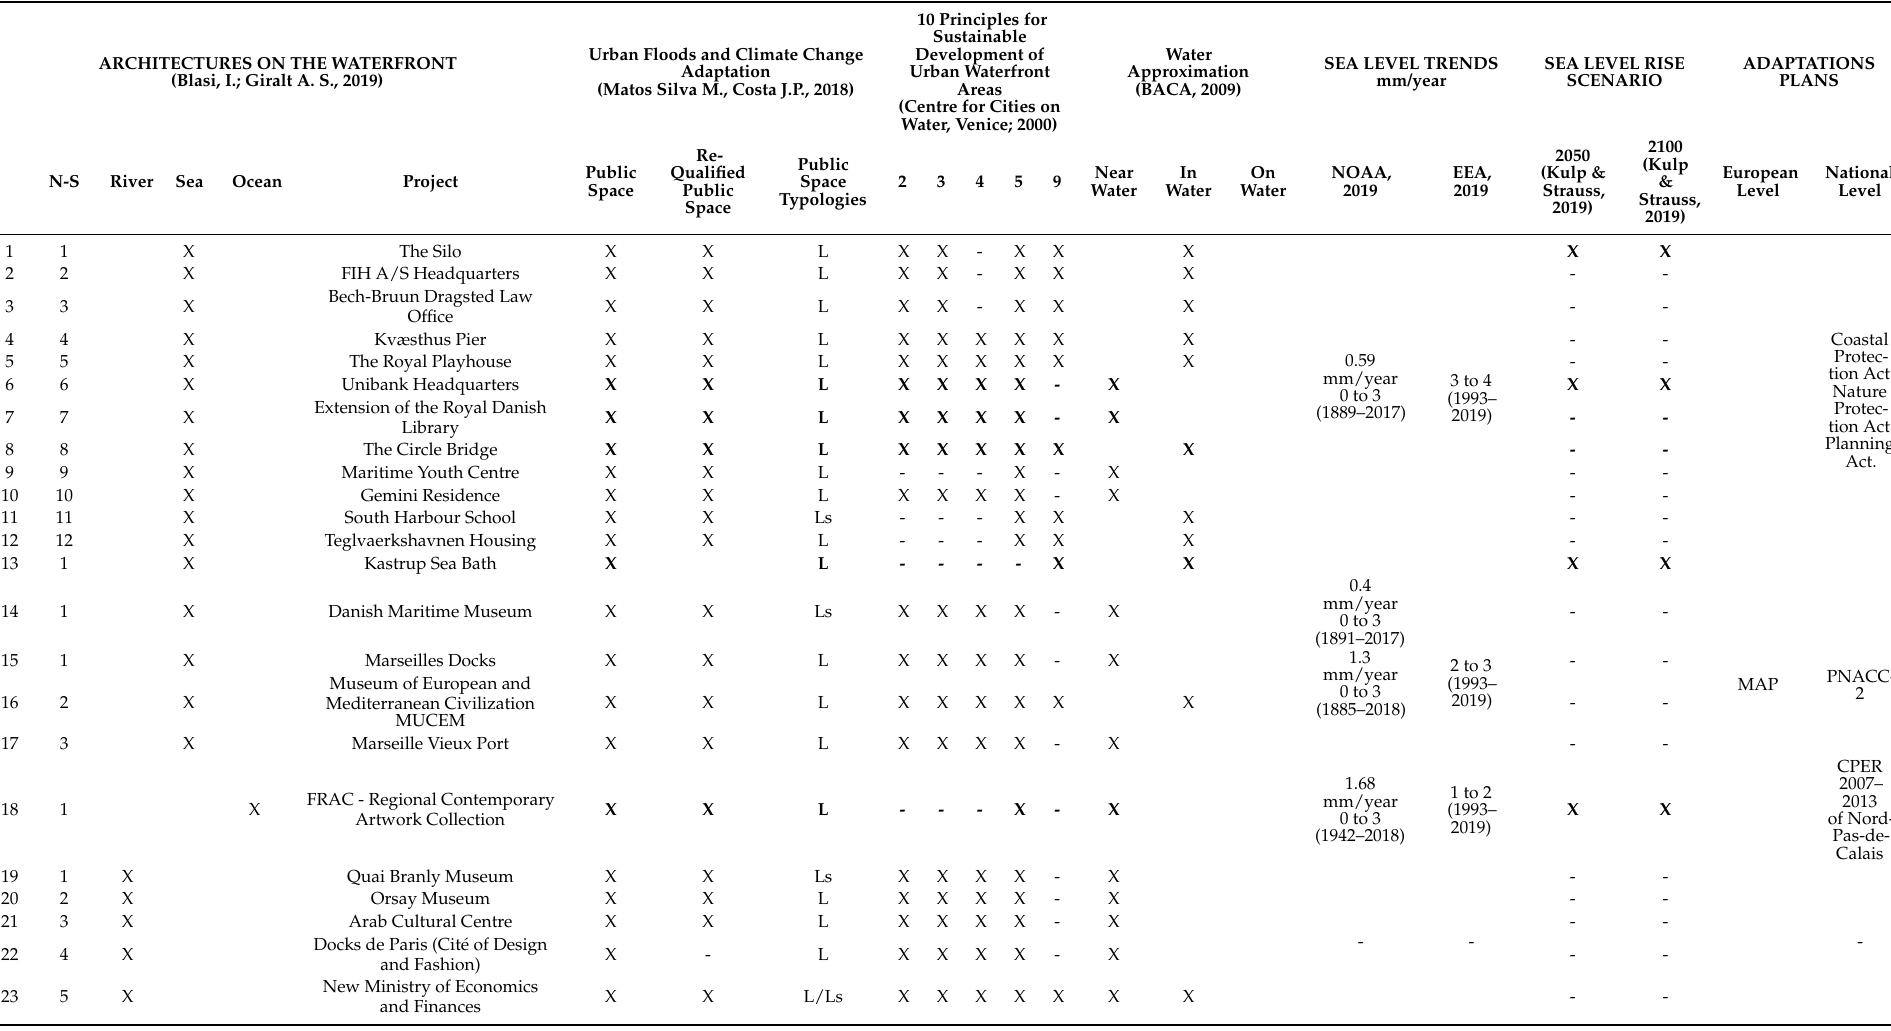
Table 3. Matrix parameters for the correlation. Authors’s Edition. Source Data: [16,39,53,55–58,60–68].